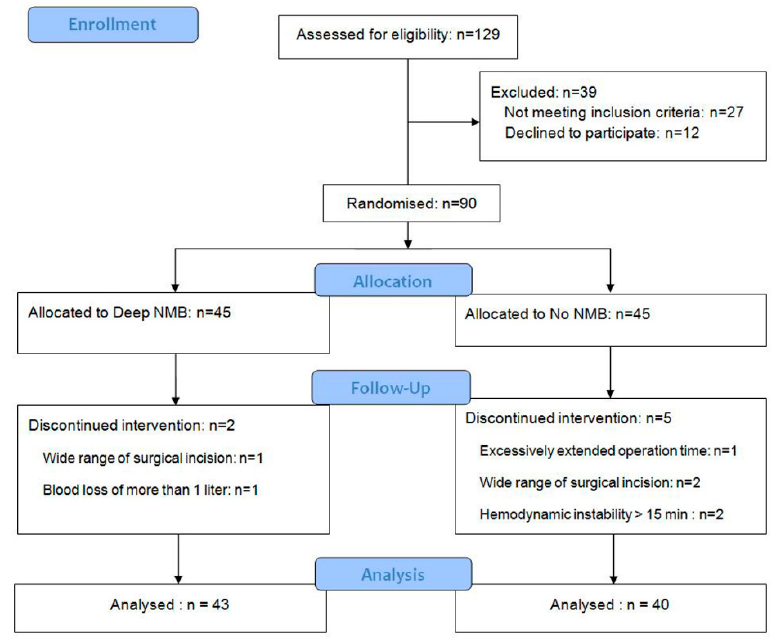
Figure 2. A flow-chart describing patient recruitment, randomization, and withdrawal. NMB: neuromuscular blockade. Table 1. Patient characteristics and clinical data.